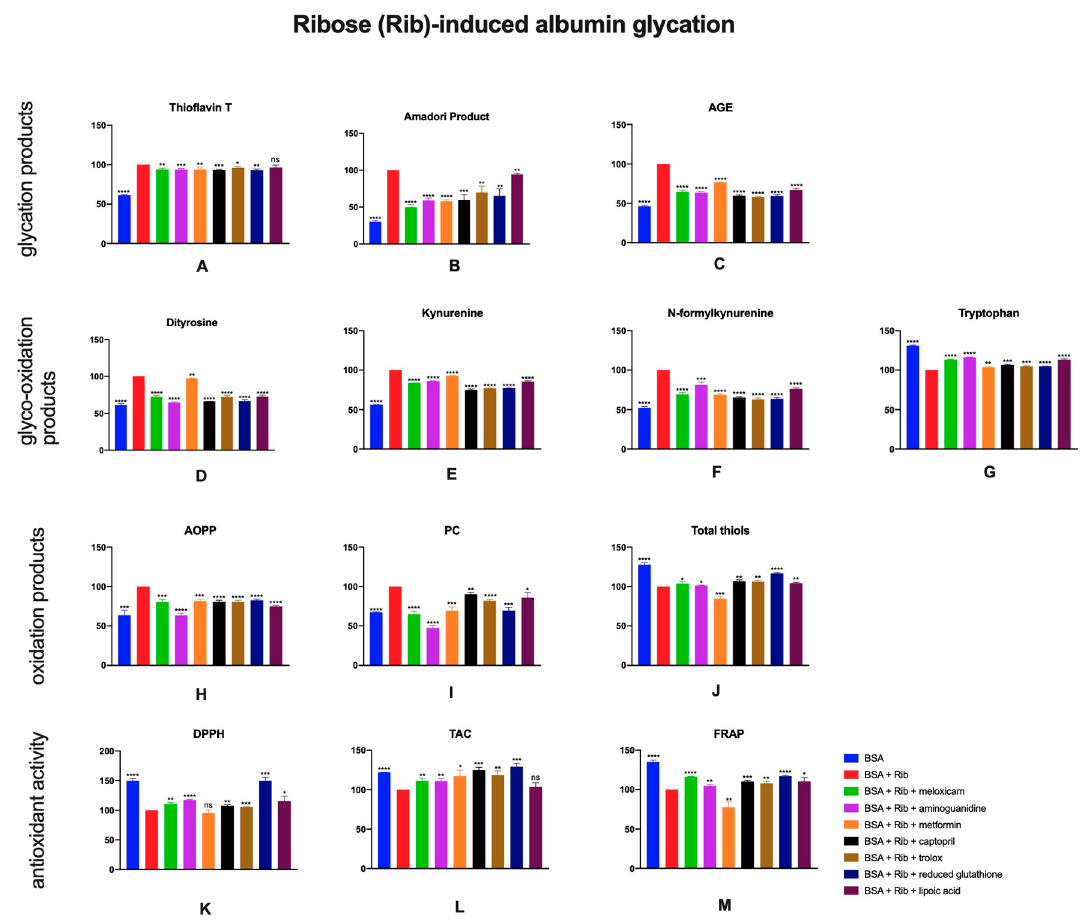
Figure 4. The effects of meloxicam, captopril, trolox, reduced glutathione, lipoic acid, aminoguanidine or metformin addition to BSA + ribose solution on protein glycation ( A – C ), glycooxidation ( D – G ) and oxidative damage ( H – J ) as well as total antioxidant potential ( K – M ). AGE: advanced glycation end products; AOPP: advanced oxidation protein products; BSA: bovine serum albumin; DPPH: 2,2-di-phenyl-1-picrylhydrazyl radical scavenging capacity; FRAP: ferric reducing antioxidant vs control; ** p < 0.01 vs control; *** p < 0.001 vs control; **** p < 0.0001 vs control.